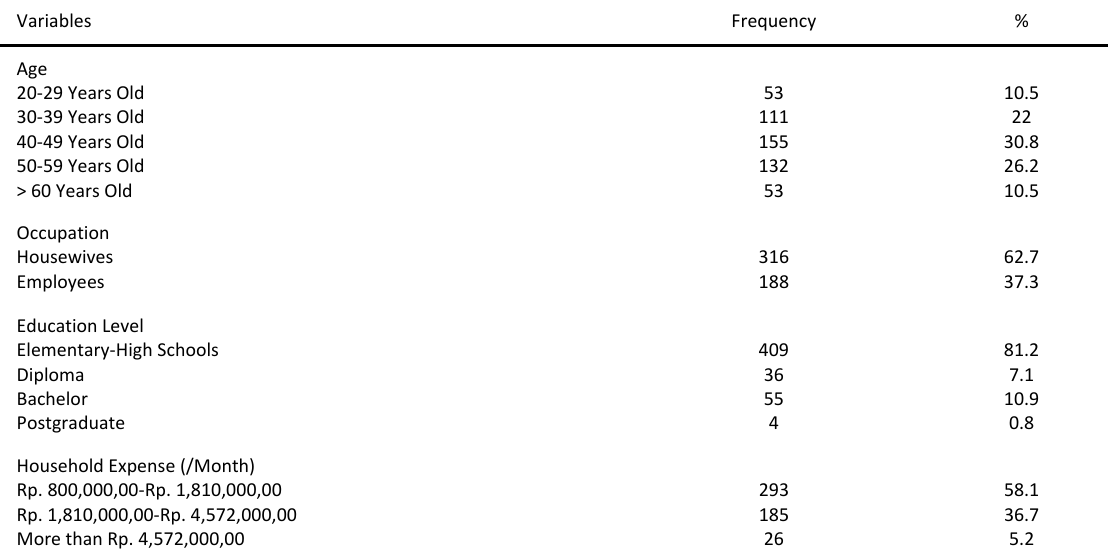
Fig. 5: The Procedure of structural model evaluation Table 3: Demographic data of respondents